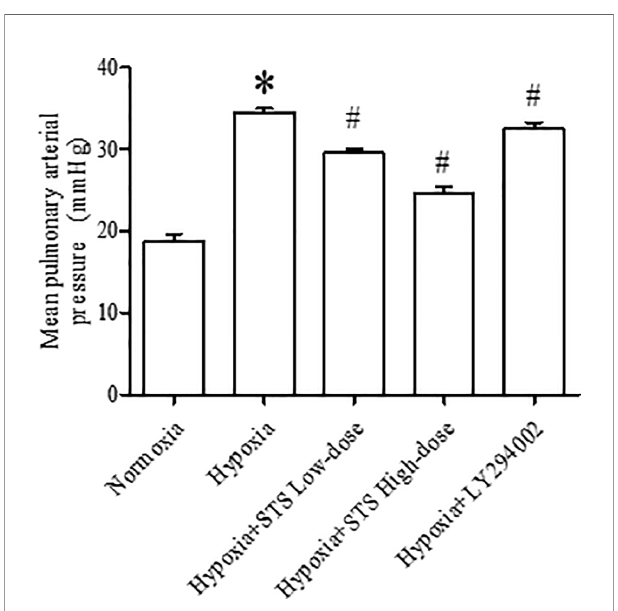
FIGURE 2 | Ratio of right ventricular/(left ventricular + interventricular septum) for each group. Data are presented as mean ± SEM (n = 8). * P < 0.05 compared with normoxia group, # P < 0.05, compared with hypoxia